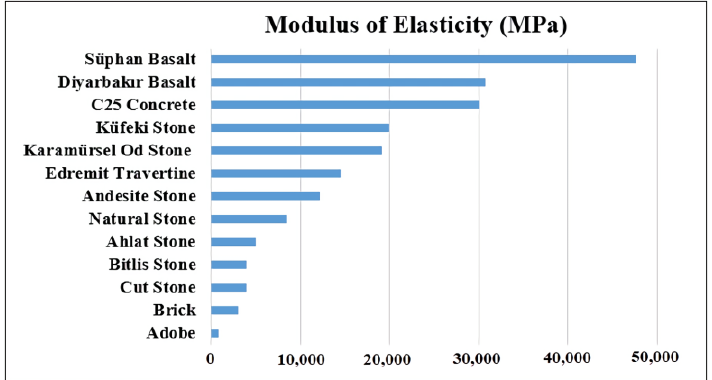
Figure 1. Comparison of the modulus of elasticity of the selected material types.